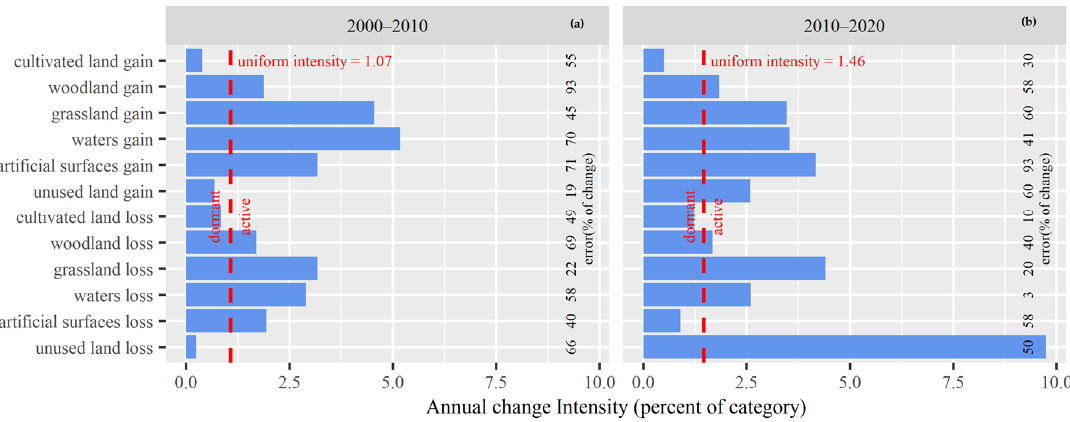
Figure 8. Category level gain and loss intensities through two time intervals for the lower reaches of the YRB. ( a ), 2000–2010; ( b ) 2010–2020.